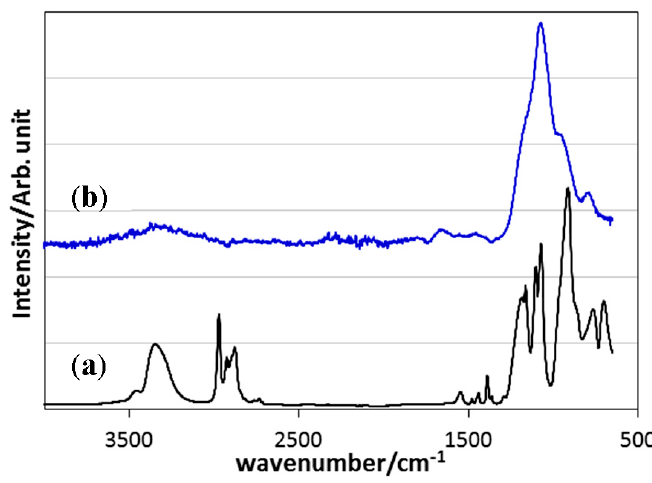
Figure 1. Attenuated Total Reflection-Infra Red (ATR-IR) spectra of ( a ) as-synthesized and ( b ) 800 °C-pyrolyzed polyethoxysilsesquiazane